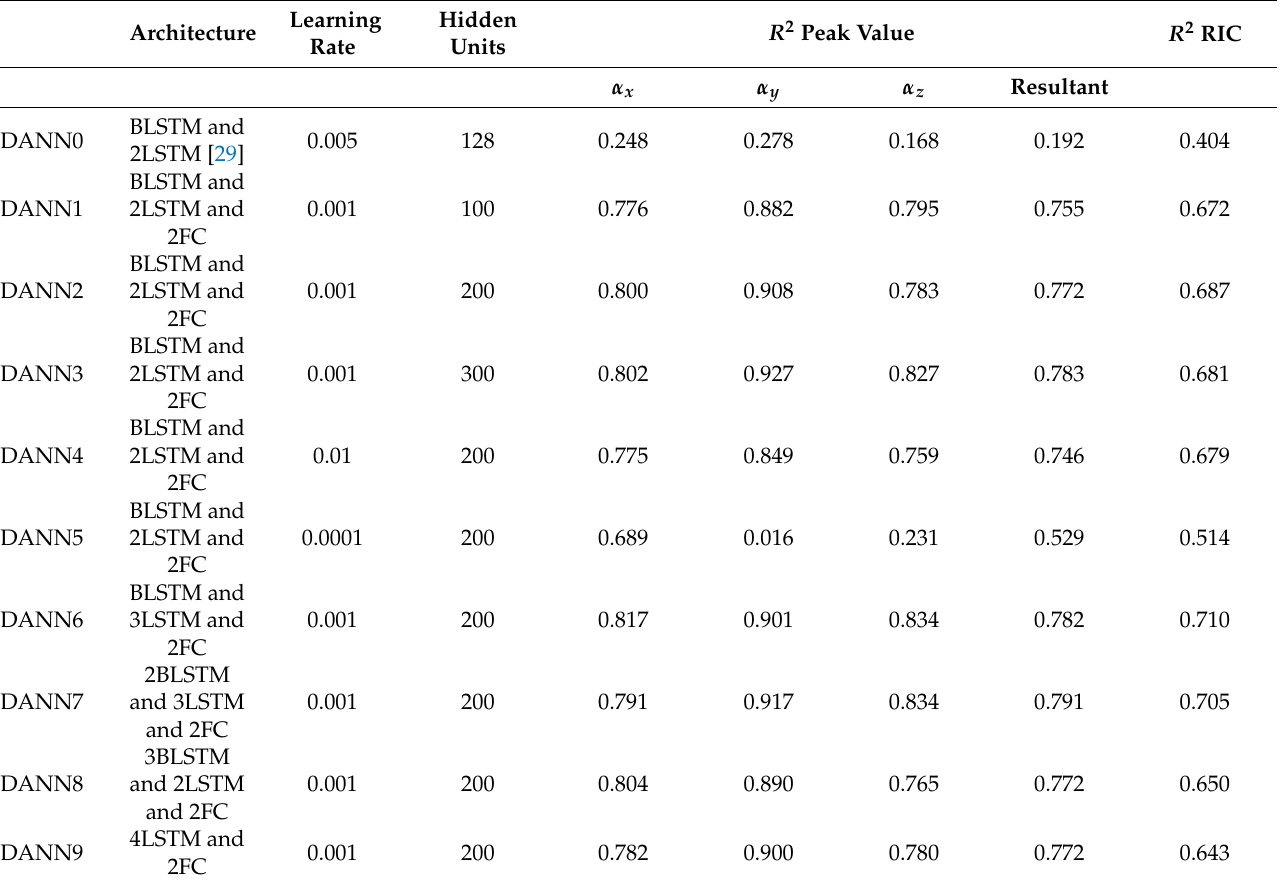
Table 1. Effect of learning rate, hidden units and architecture in the peak values and RIC